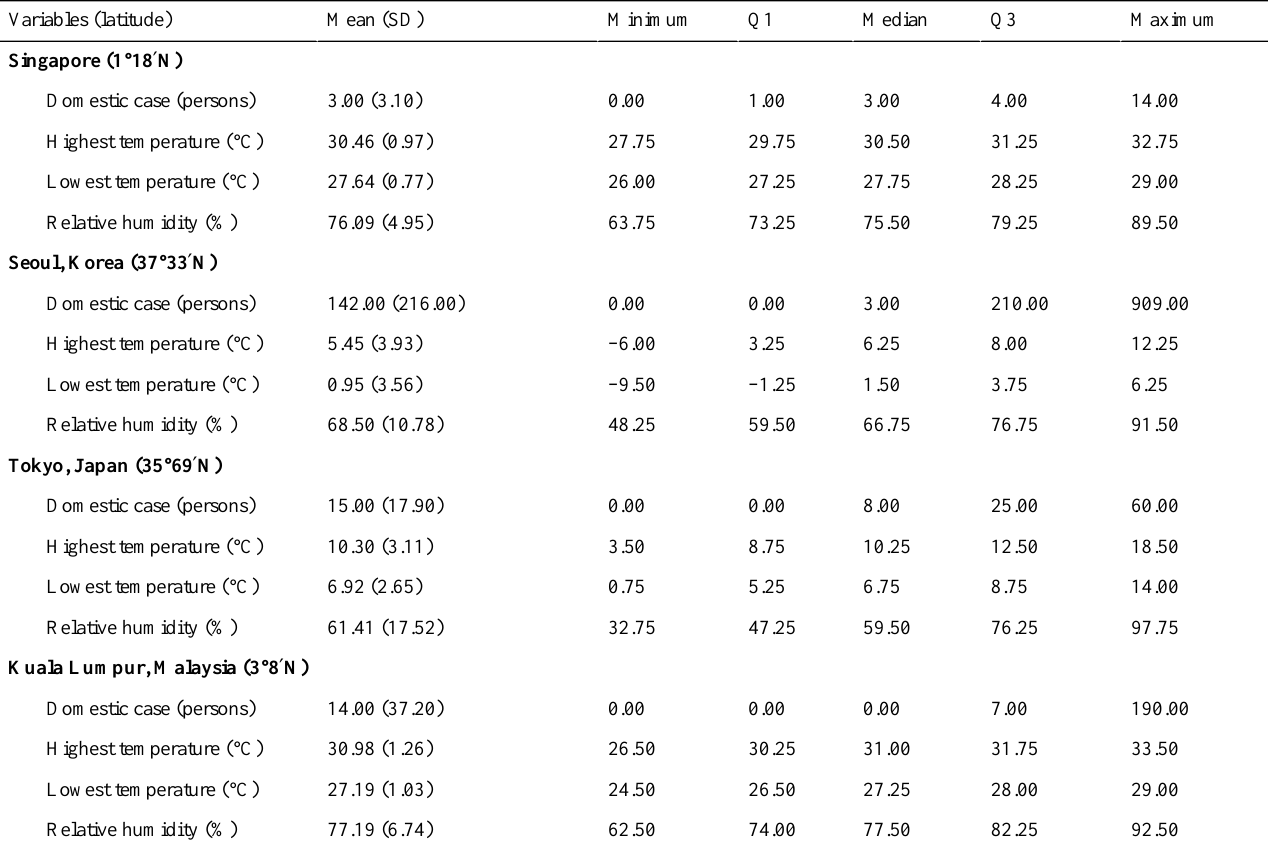
Table 2. Descriptive statistics for different Asian cities,